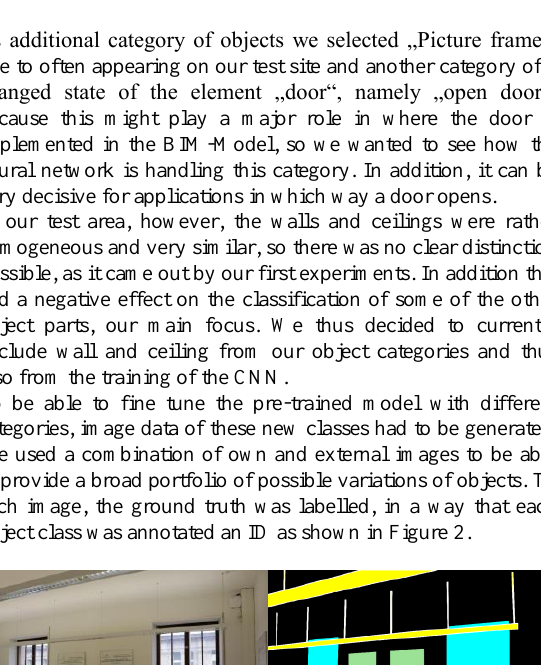
Table 1. Used categories of major object parts, connecting object parts, objects of interest and additional objects.